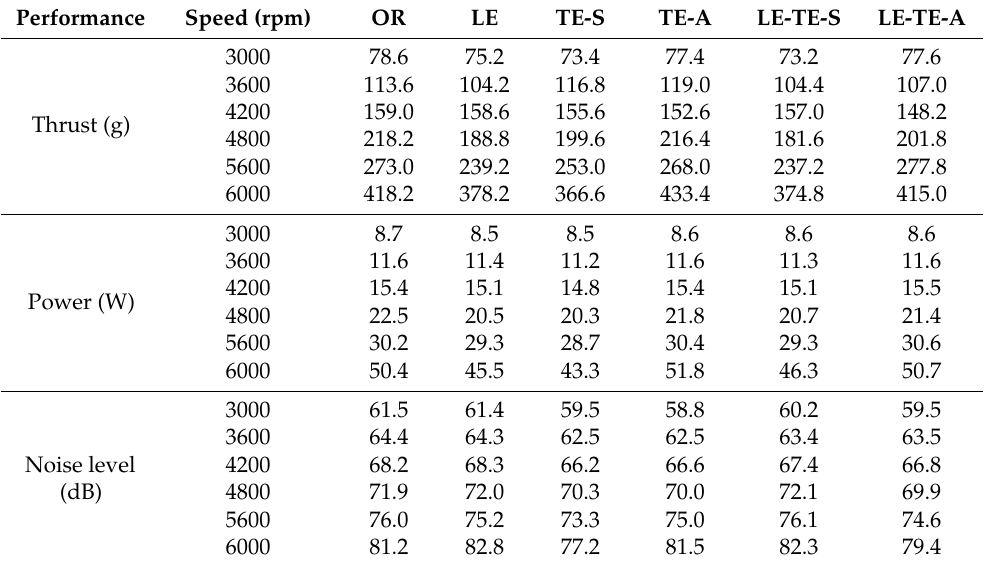
Table 6. Comparison on aerodynamic and acoustic performance of different rotors with PA 12 (rounding to the one decimal place).